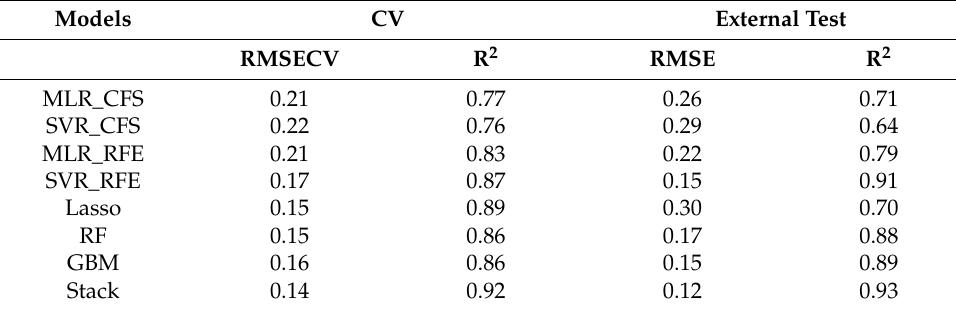
Table 5. Prediction performances of all models at pH